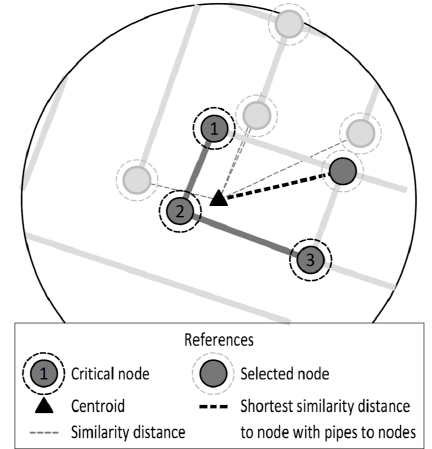
Figure 3. Selection of the node with shortest similarity distance with the pipe to be clustered.